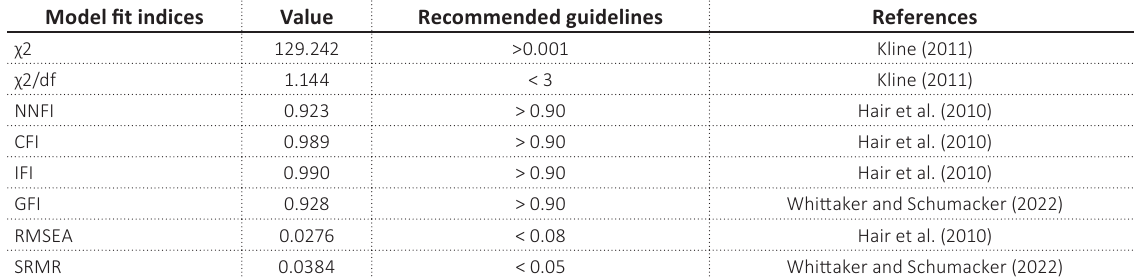
Table 4. SEM fit